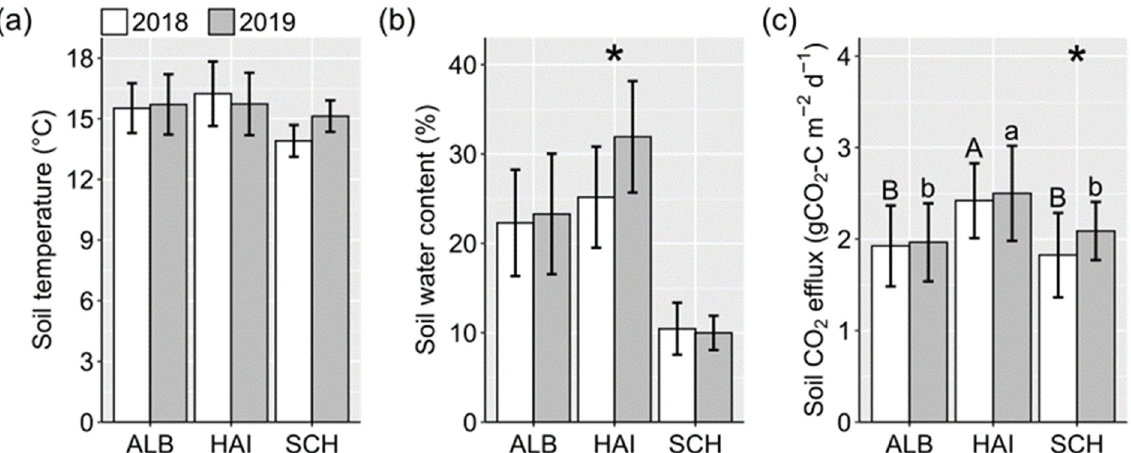
Figure 2. ( a ) Soil temperature, ( b ) volumetric water content and ( c ) in situ soil CO 2 efflux from the forest sites of the Biodiversity Exploratories project (i.e., 50 forest sites in ALB, 50 in SCH and 49 in HAI) in 2018 and 2019. Bars represent mean values, and the error bars represent standard deviations. Upper case letters indicate differences among the study regions in 2018 and lower case letters indicate differences in 2019. Asterisks indicate differences between the years for a given study region.